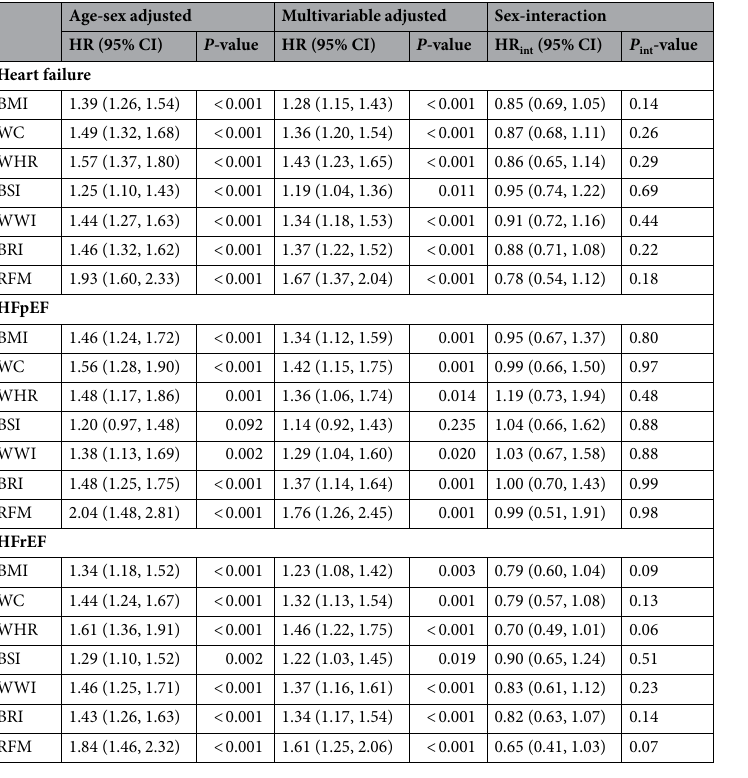
Table 2. Associations of adiposity indices with incident heart failure and its subtypes. Multivariable models were adjusted for age, sex, smoking, cholesterol, systolic blood pressure, glucose, and history of myocardial infarction, stroke and atrial fibrillation. HR represents the hazard ratio per standard deviation change in adiposity index; CI represents confidence interval; P int represents the P-value for sex × covariate interaction. A hazard ratio for interaction (HR int ) > 1 indicates stronger associations in women. A HR int < 1 indicates stronger associations in men. BMI body-mass index, BRI body roundness index, BSI body shape index, HF heart failure, HFrEF HF with reduced ejection fraction, HFpEF HF with preserved ejection fraction, RFM relative fat mass, WC waist circumference, WHR waist-to-hip ratio, WWI weight-adjusted-waist